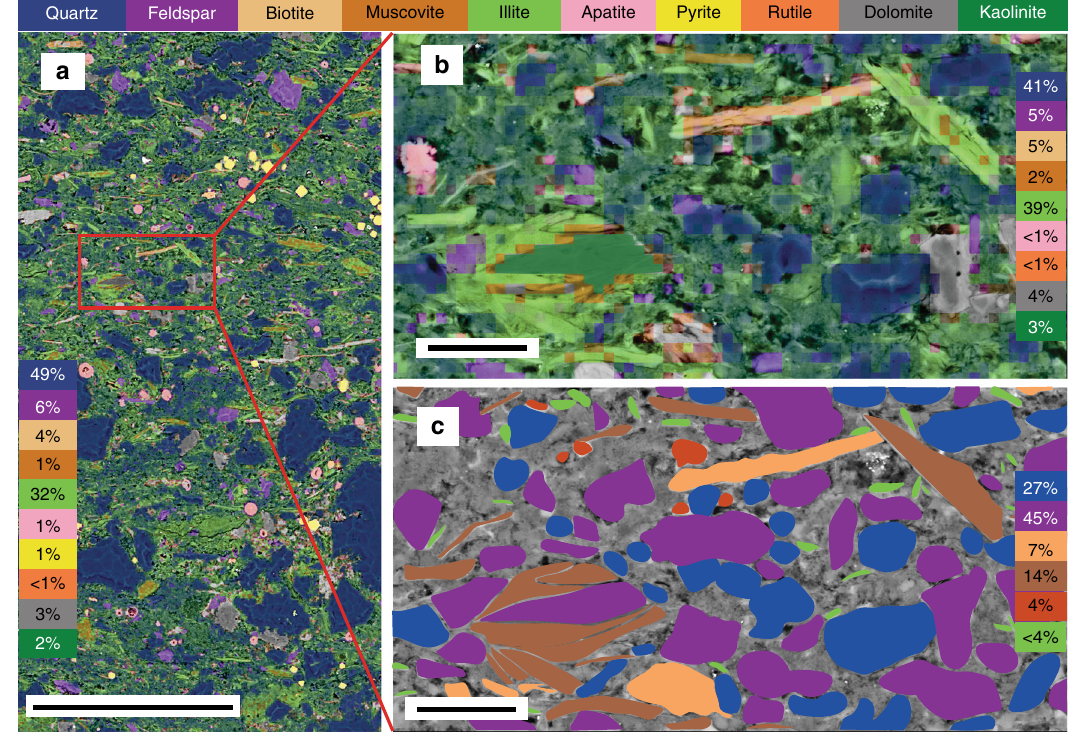
Fig. 3 SEM backscatter image with Nanomin mineral map overlay from a dark fi ne-grained lamina in Urapunga 4 core. a A mineral map showing the distribution and composition of grains with quanti fi ed percentage of weight percent calculated from area showing quartz and illite to be the dominant mineral phases. Scale bar = 100 μ m. b Zoomed in image from the box in a provides detail of the detrital silt grains, replacement minerals and intergranular micro quartz cement with minerals quanti fi ed for this area as in a. Scale bar = 10 μ m. c Primary detrital constituent map of image b with replaced areas returned to likely original phases and intergranular cement left as background BSE image. Correction is based on relict crystal forms evident in BSE. Quanti fi ed normalized values for the area show feldspar is dominant with quartz, mica, and only a small component of detrital illite. Illite present in replaced mica and feldspar is 32% of the 39% in image b leaving a maximum of 7% that could have been deposited as DCM. C is a micaceous arkosic siltstone with a calculated CIA value of 58% indicative of low chemical weathering. The original sample from the core was taken from the fi nest-grained laminae, has a signi fi cant illite fraction (32%) and a CIA index of 73% suggestive of intense weathering resulting from illite replacement of feldspar and mica after